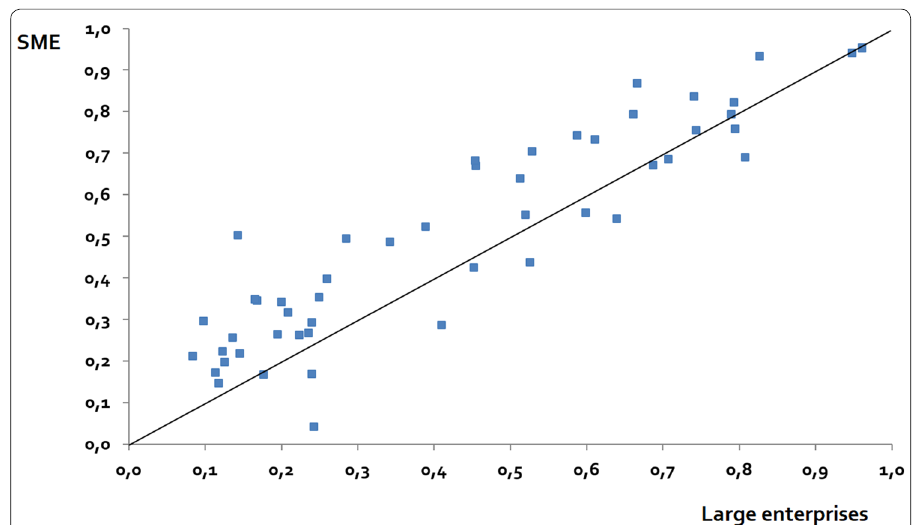
Fig. 4 Indirect value added as share of total value added, by industry and size class,